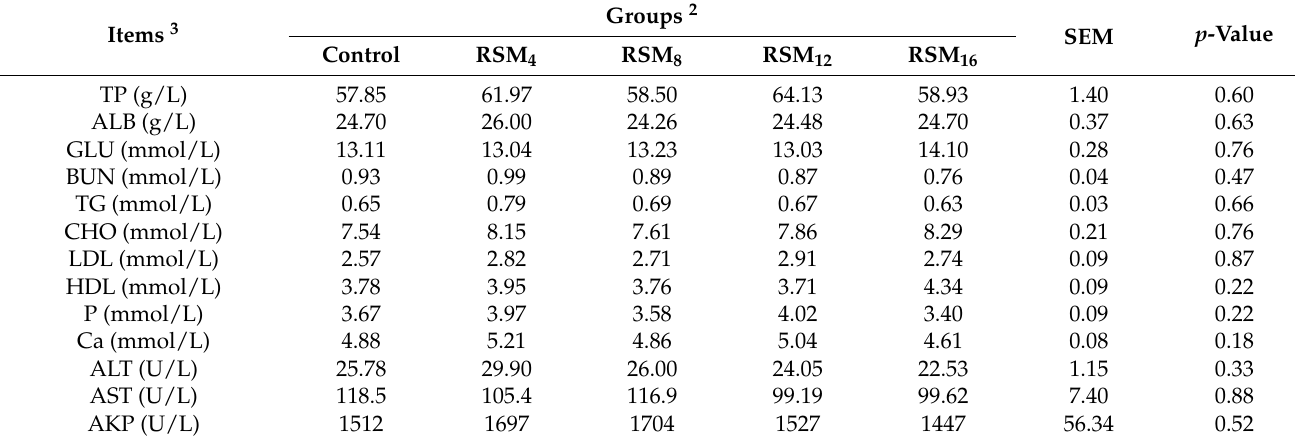
Table 6. Effects of increasing dietary levels of rapeseed meal on serum biochemical parameters of geese at 70 d of age 1